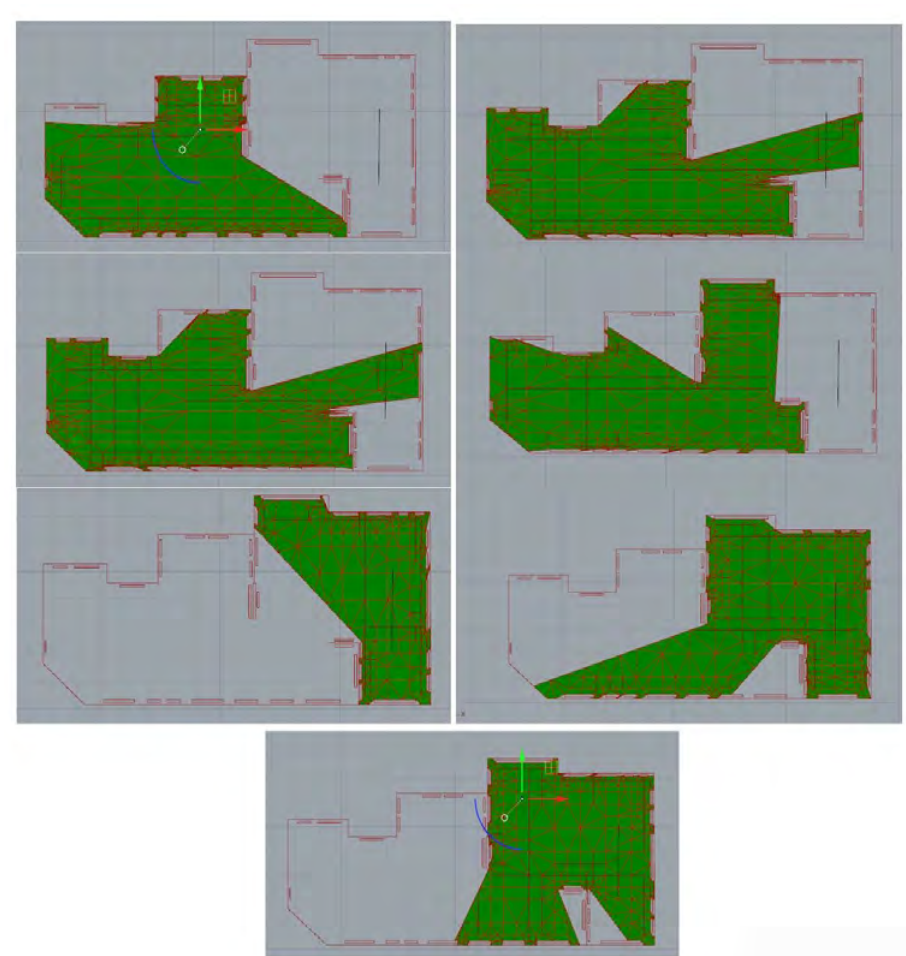
Figure 5. Visibility Analysis using smart space analyzer